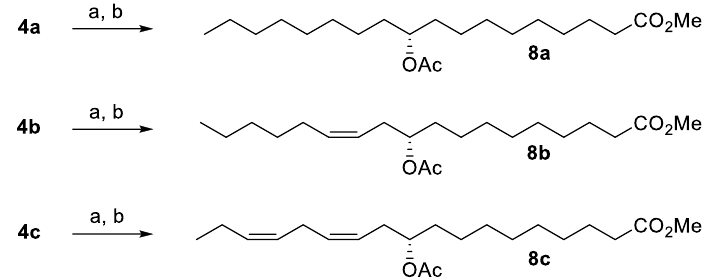
Figure 4. Transformation of 10-hydroxystearic, (12 Z )-10-hydroxy-octadecenoic and (12 Z ,15 Z )-10- hydroxy-octadecadienoic acids 4a – c to the corresponding derivatives 8a – c . Reagents and conditions: (a) CH 2 N 2 , Et 2 O, 0 °C; (b) Ac 2 O/Py, DMPA cat., RT.